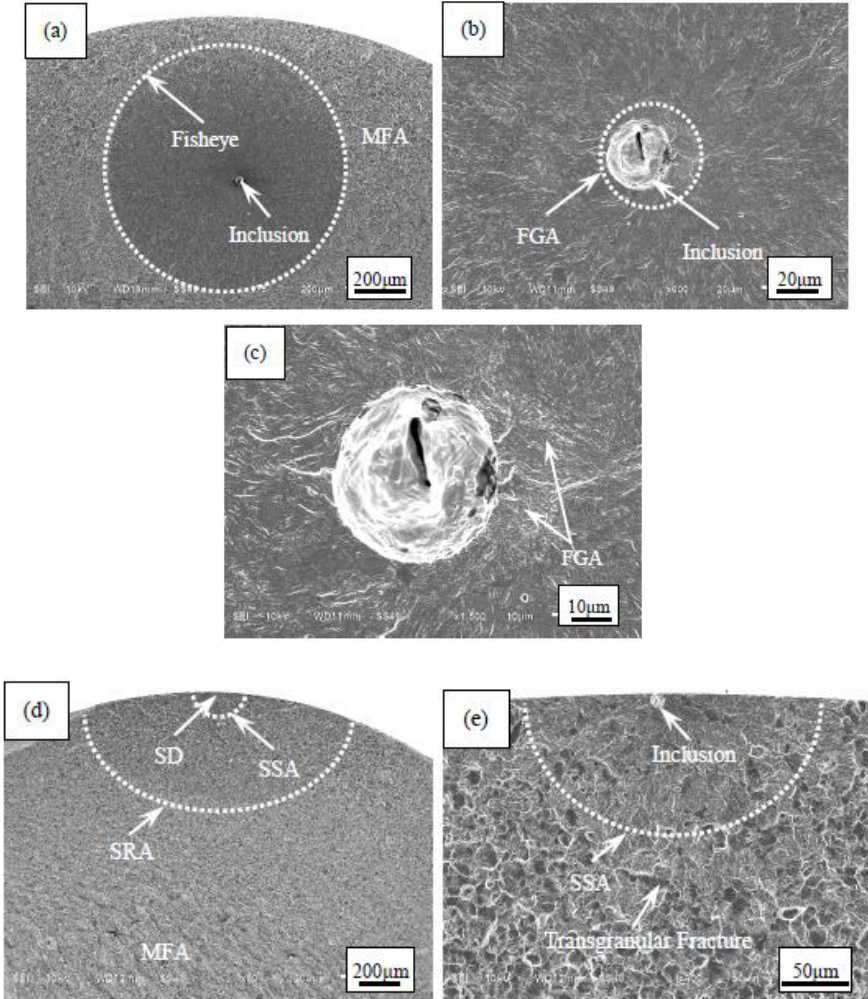
Figure 5. Observation of fatigue fracture surfaces: ( a ) fisheye; ( b ) inclusion with fine granular area (FGA); ( c ) inclusion with FGA at high magnification ( σ a = 575 MPa, N f = 4,254,700 cycles, R = 0); ( d ) surface-induced failure; ( e ) inclusion ( σ a = 650 MPa, N f = 82,100 cycles, R = 0).